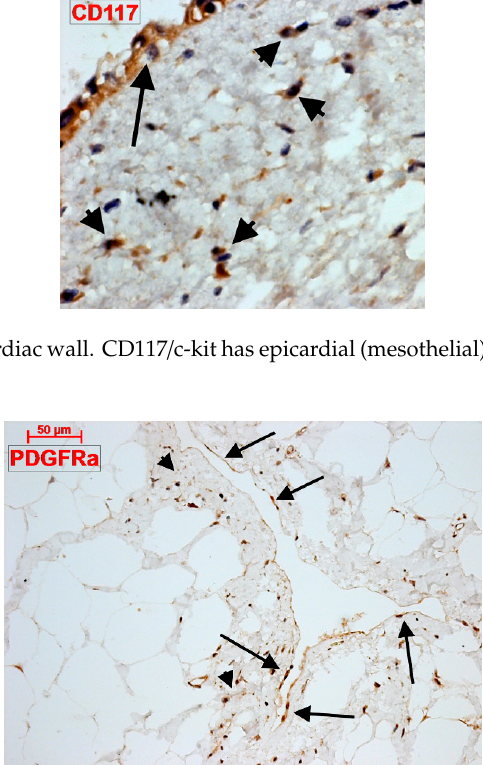
Figure 5. Human adult cardiac wall. Immediate submesothelial expression of CD34 includes nascent endothelial tubes (arrows). 4. Discussion 4.1. The Epicardial Lymphatics The cardiac lymph is drained through the initial lymphatics from the subendocardial lymphatic plexus to Sappey’s subepicardial lymphatic plexus via intramyocardial lymphatic channels; precollecting vessels from the subepicardial plexus further drain into collecting vessels neighboring the major coronary branches [26]. Here, we detected the immediate submesothelial location of Sappey’s subepicardial lymphatic plexus, which consists of lymphatic vessels with circumferential dispositions. As lymphatics were overlooked in tissue samples in which cardiac ICLCs/TCs were discriminated [26], the molecular anatomy of the epicardial niche must be revisited. 4.2. C-Kit-Positive Cardiac Cells The c-kit protein (CD117) is a type III tyrosine-protein kinase that recognises the stem cell factor (SCF) ligand [34]. During development, the c-kit receptor is expressed both in cardiac progenitors capable of cardiomyogenesis and in others with divergent evolution patterns [35]. This receptor–